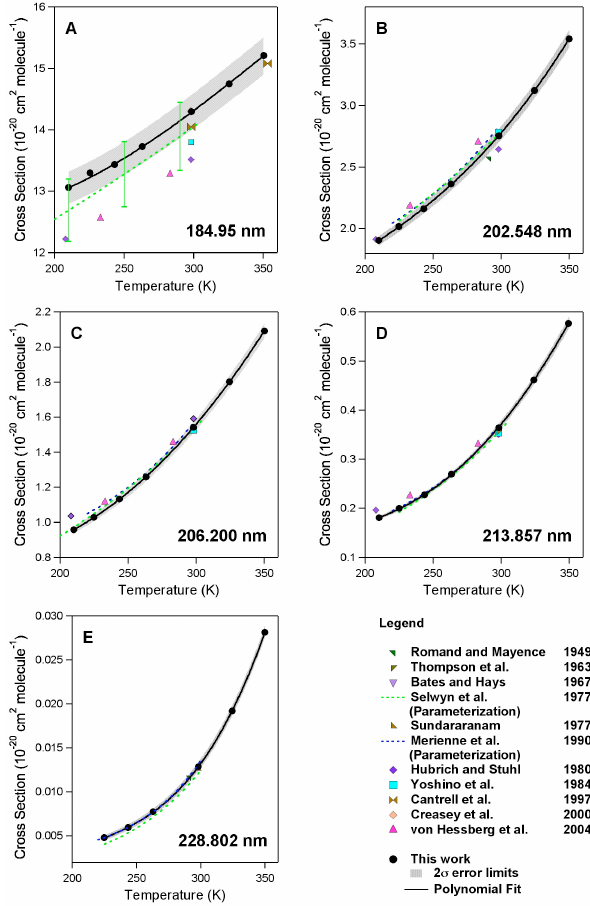
Fig. 2. Temperature dependent N 2 O absorption cross sections ob- tained in this work ( • ). The shaded region represents the estimated absolute 2 σ (95% confidence level) uncertainty from our work in- cluding estimated systematic errors. Included for comparison are results from previous studies as indicated in the legend. The data from M´erienne et al. (1990) and Selwyn et al. (1977) are plotted using the cross section and temperature dependence parameteriza- tions reported in their work. Data from Zelikoff et al. (1953) are not included due to their large deviation from the other studies. The re- sults from Selwyn et al. (1977) supersedes the results from Johnston and Selwyn (1975), which are not